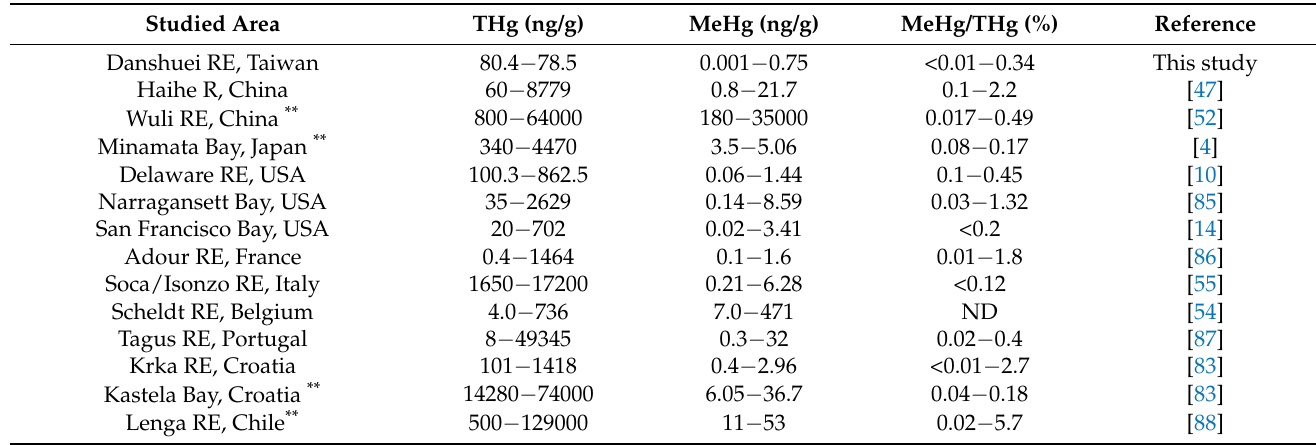
Table 3. Comparison of concentration ranges for total Hg (THg) and methyl Hg (MeHg), and the percentage of methyl Hg to total Hg in sediment obtained from the Danshuei River Estuary with other eutrophic estuaries elsewhere in the world. Studied Area THg (ng/g) MeHg (ng/g) MeHg/THg (%) Reference Danshuei RE, Taiwan 80.4 − 78.5 0.001 − 0.75 <0.01 − 0.34 This study 60 −